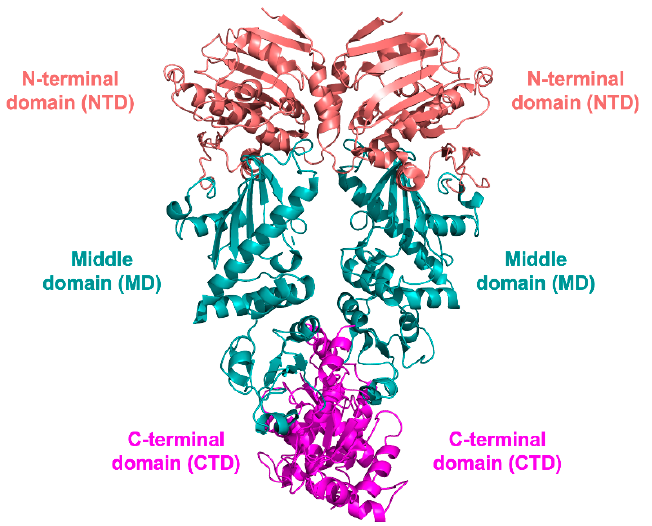
Figure 1. Cartoon representation of the dimeric full-length Saccharomyces cerevisiae HSP90 in complex with the cochaperone p23 and the ATP analogue adenosine-5-( β , γ -imido)triphosphate (AMP-PNP; PDB id 2CG9 [58]). The NTD is colored coral, the MD cyan, and the CTD magenta.